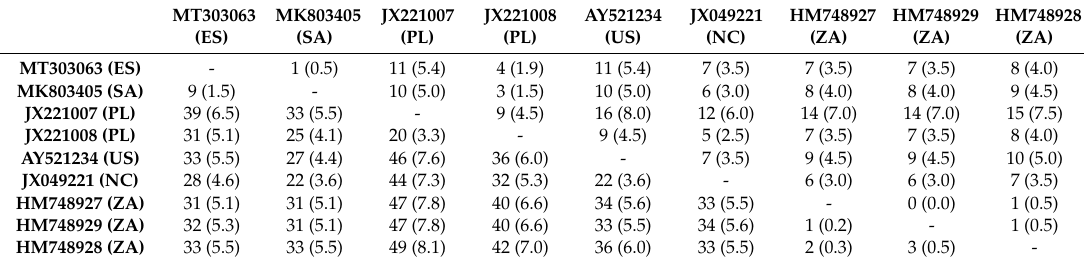
Table 1. Number of nucleotide (below diagonal) and amino acid (above diagonal) variations between partial sequences of the BFDV rep gene isolated from rose-ringed parakeets ( Psittacula krameri ). The percentage of variation considering the sequence length (603 nucleotides and 201 amino acids) is noted in